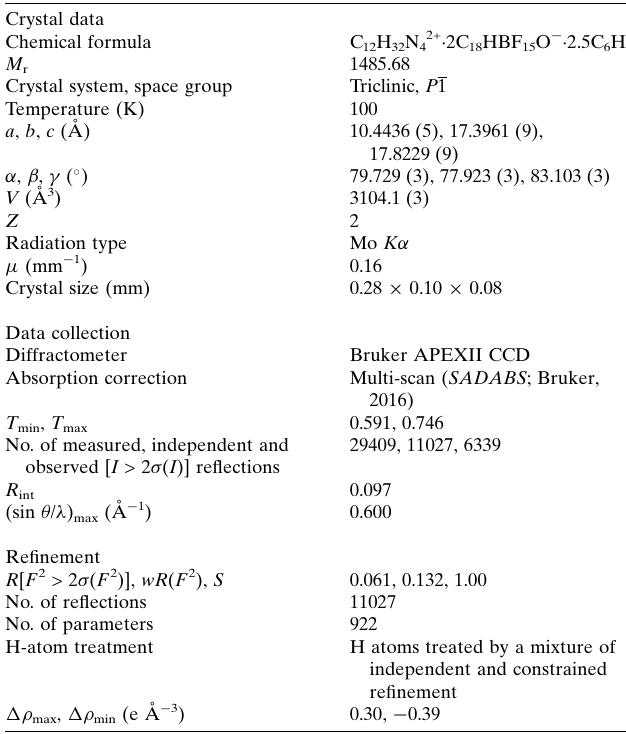
Table 2 Experimental details. Crystal data Chemical